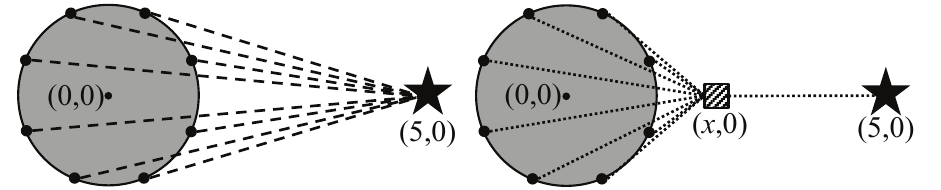
Figure 8. Mathematical models of individual location update ( left ) and integrated location update ( right